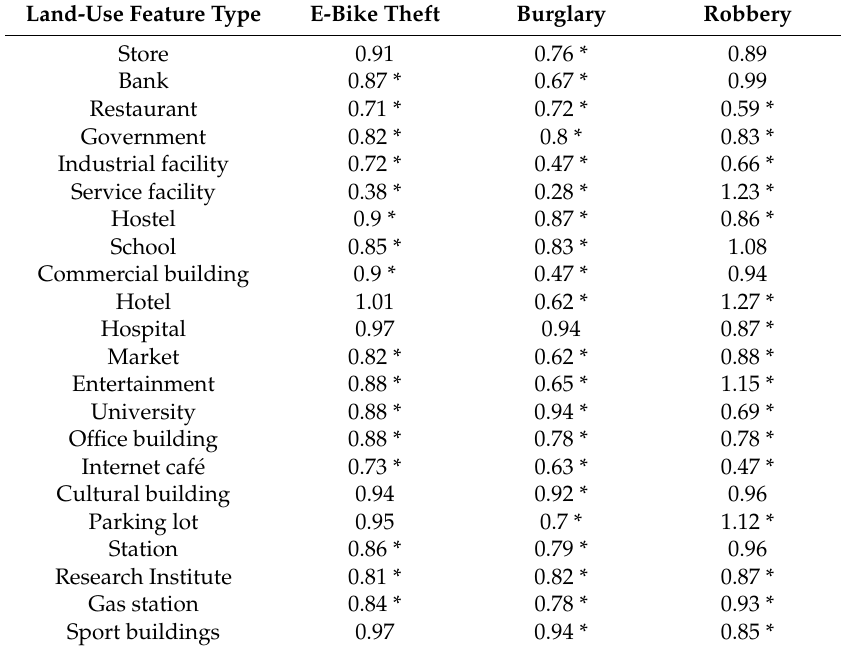
Table 3. Global colocation quotients of three types of crimes and land-use